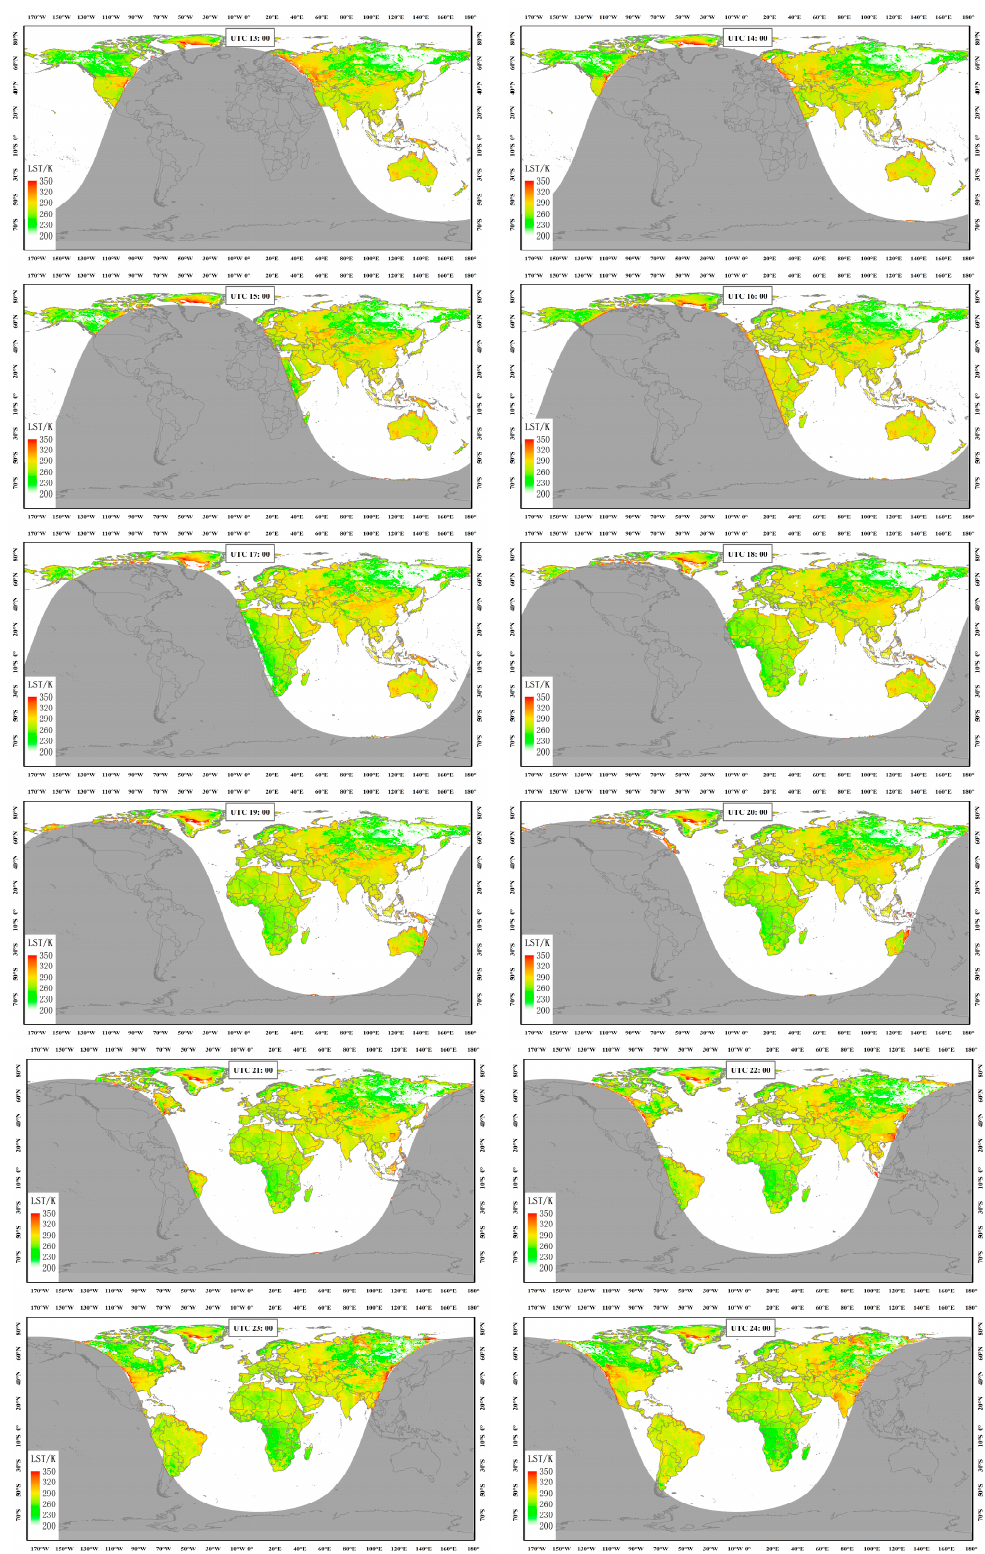
Figure 3. The land surface temperature (LST) estimation results from the lunar base at 1:00–24:00 2